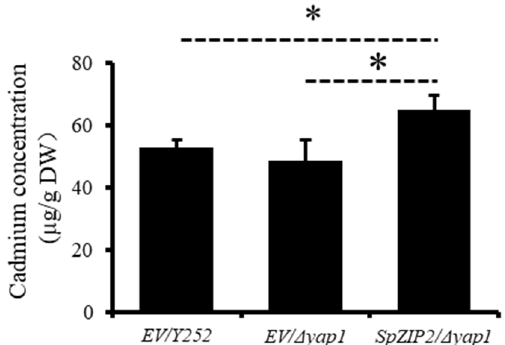
Figure 6. Cd accumulation in SpZIP2 expressed Δ yap1 and empty vector transferred yeast Y252 and Δ yap1 . Values are means ± SD, n = 3. Statistical significance was tested by Student’s t -tests. Differ- ences were deemed significant at p < 0.05 (*).